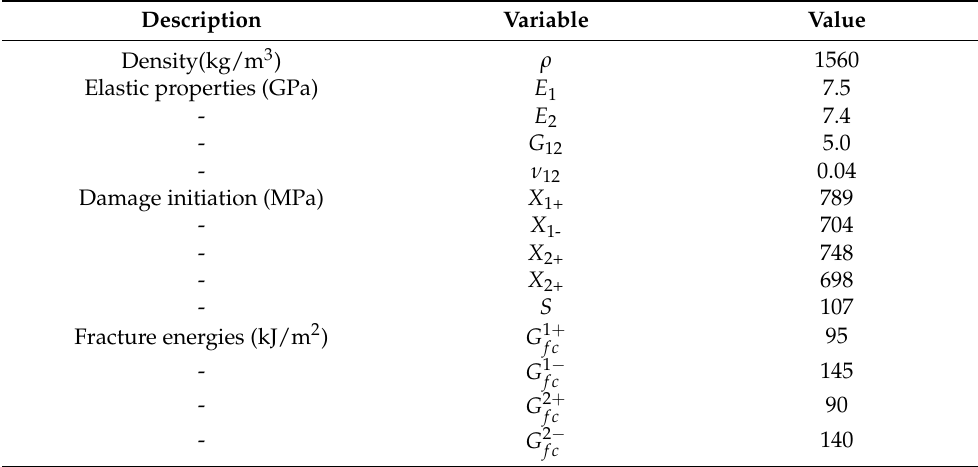
Table 2. Material parameters of the elastic and failure behaviors along the fiber directions. Description